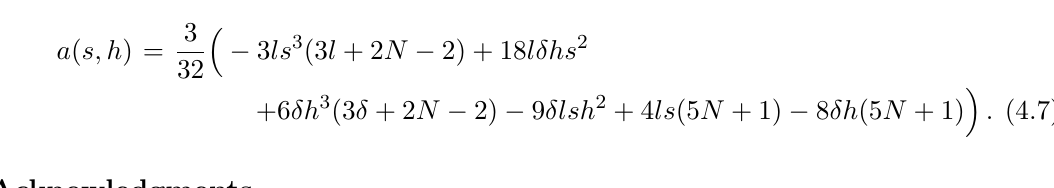
Figure 8. Theory obtained by gluing together two tubes with di(cid:11)erent (cid:13)ux. One is with r = l and the other one with l + (cid:14) . The lines will follow the obvious orientation pattern from (cid:12)gure 5. superconformal R symmetry is obtained by